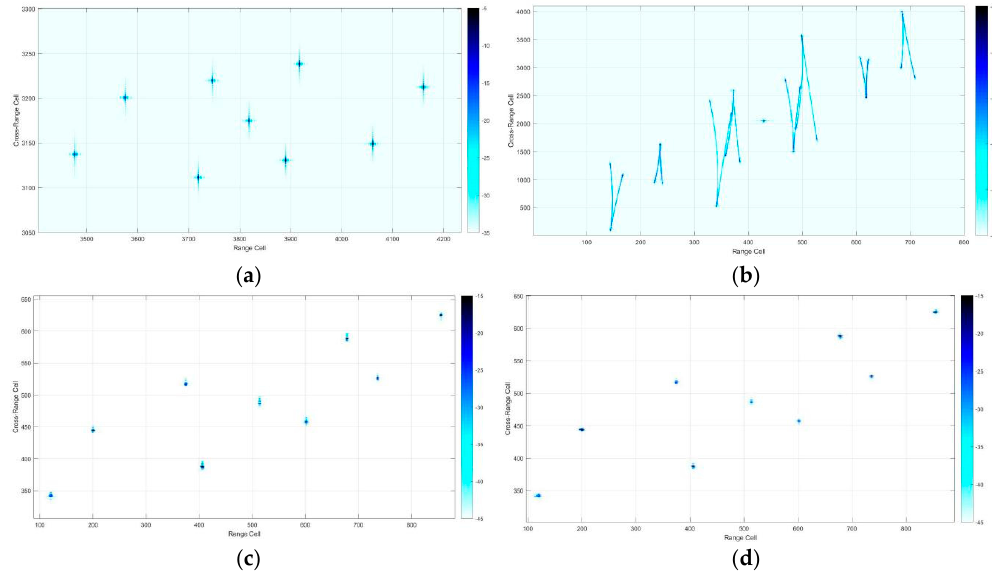
Figure 3. Imaging results of the vessel scattering point model: ( a ) imaging result of a simulated stationary vessel; ( b ) imaging result of a simulated moving vessel; ( c ) imaging result of classical PSO; ( d ) imaging result of co-evolutionary PSO.